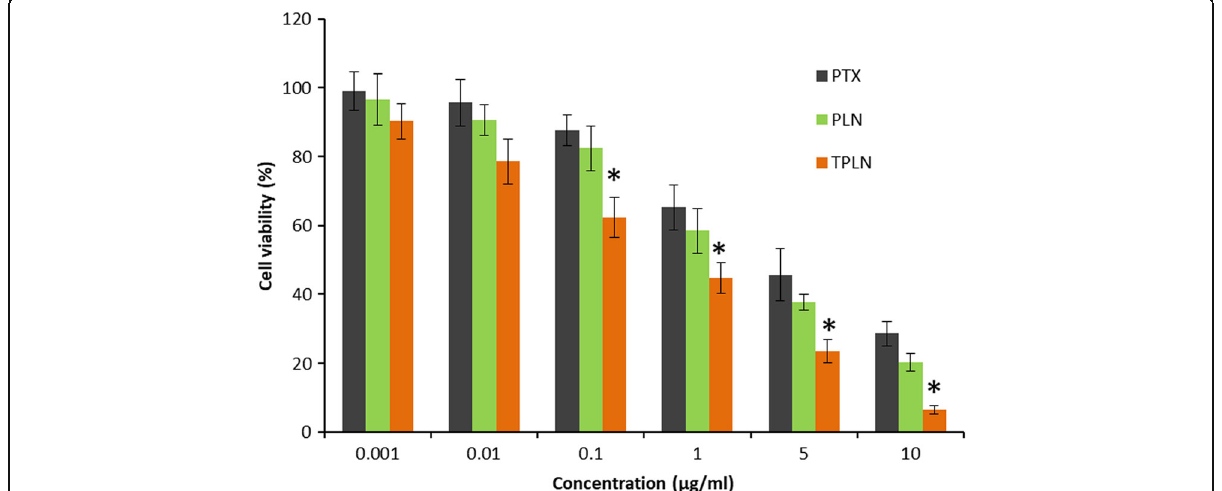
Fig. 5 Cytotoxicity analysis of free drug and drug-loaded nanoparticle by MTT assay. After treating the cells with different concentration of drugs and incubated for 24 h, cells were analyzed by MTT assay and using a plate reader. The measurement was performed n =6. * p <0.05 is the statistical difference between TPLN and PTX